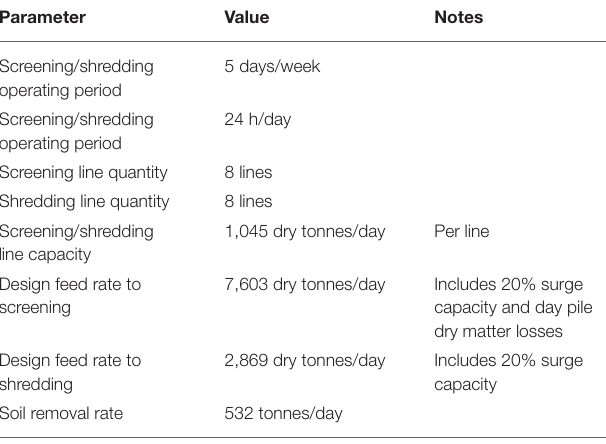
TABLE 5 | Screening/shredding system design summary for preprocessing operations of the chopped logistics